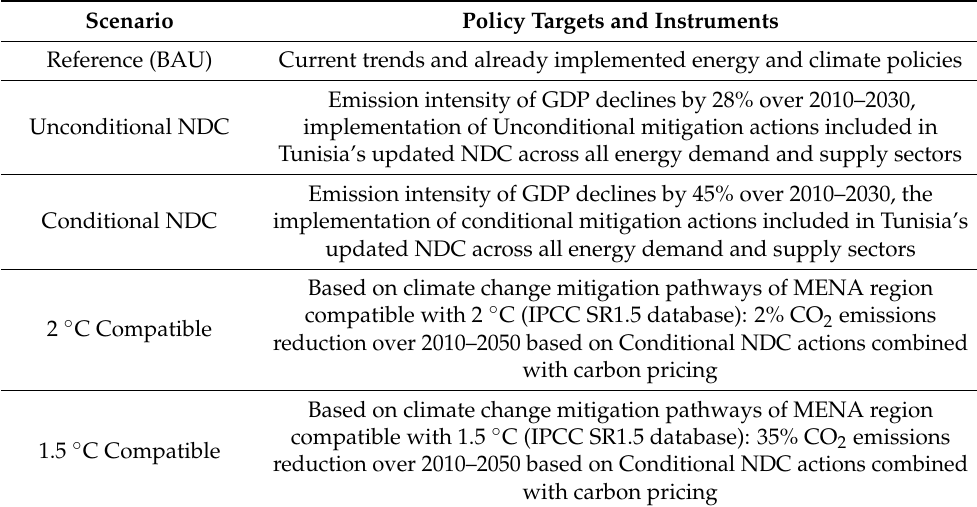
Table 1. Summary of key assumptions used in policy scenarios, source of data